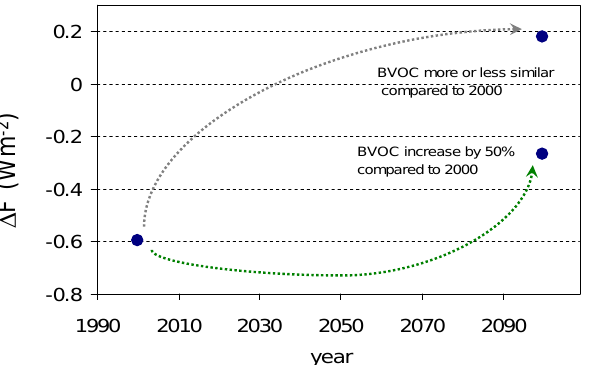
Fig. 4. Difference in (mean) total anthropogenic aerosol radiative forcing (Wm − 2 ) between simulations with and without account- ing for effects of new particle formation (–0.6Wm − 2 for present- day conditions). Simulations in 2100 reflect anthropogenic emission changes, with the additional effect of biogenic emissions (monoter- penes) being more or less unchanged compared to present day, and with an assumed increase of monoterpene emissions by 50%. Fig- ure is redrawn from Makkonen et al. (2012). Dotted lines do not represent modelled trajectories between present day and late 21st